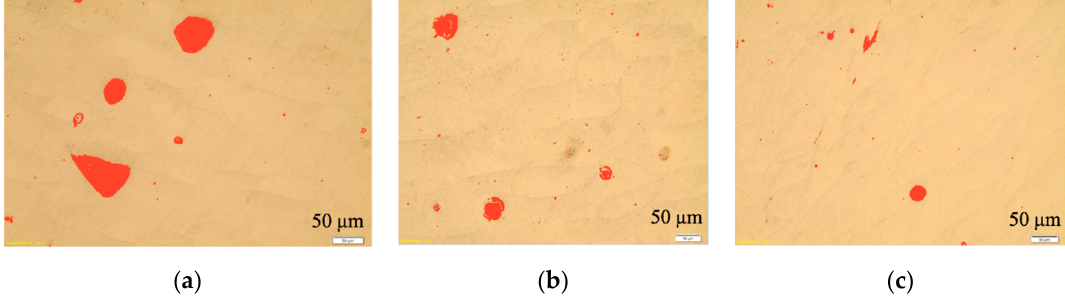
Figure 8. Analysis of the pores percentage in the respective intersections as explained in the Figure 5: ( a ) intersection 1; ( b ) intersection 2; ( c ) intersection 3.